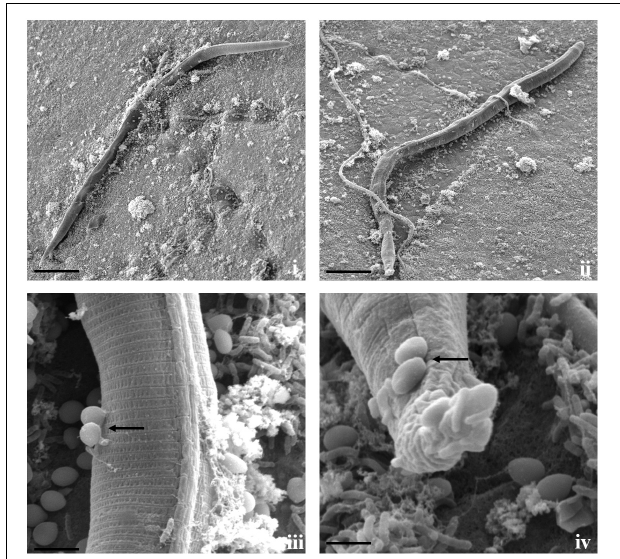
FIGURE 5 | Scanning electron micrographs of interaction between T. cylindrosporum Tc_RK and M. incognita . (i,ii) Fungal colonization and parasitization on nematode cuticle (scale bar = 20 µ m), (iii,iv) attachment of fungal spores onto nematode cuticle (black arrow) followed by spore germination (scale bar = 2 µ